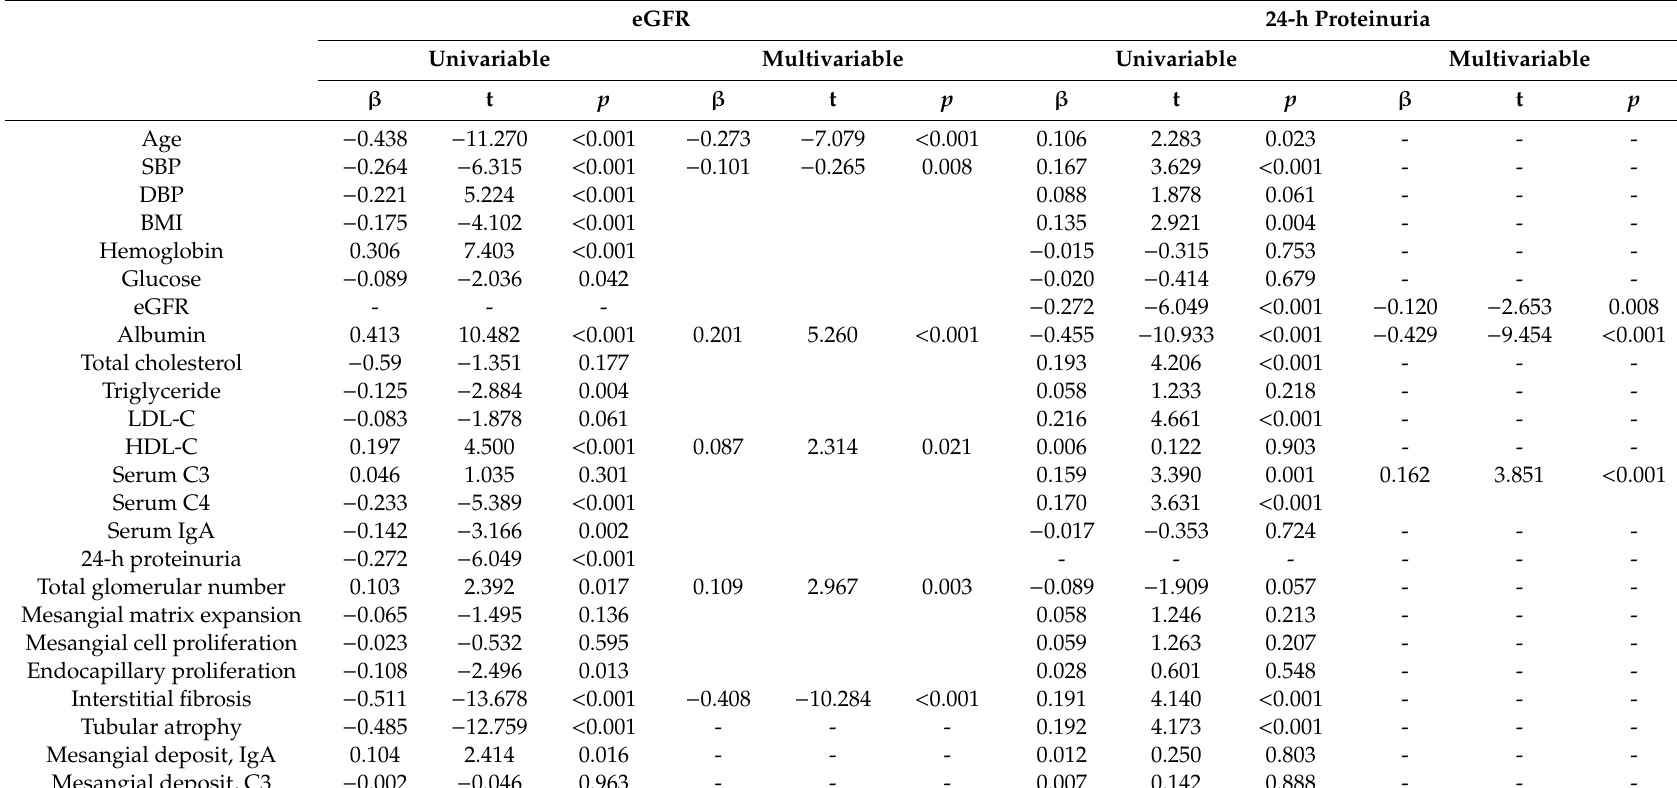
Table 6. Linear regression analysis for renal function and 24-h